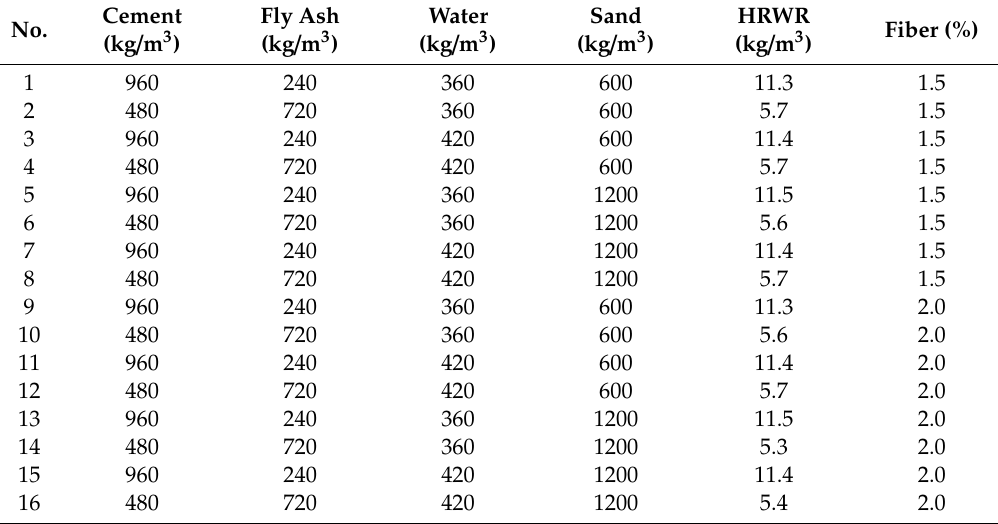
Table 4. Mix proportions of